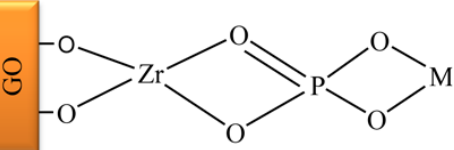
Figure 2. Schematic representation of the adsorption of a metal ion onto GO – ZrP ([74], with per- mission of